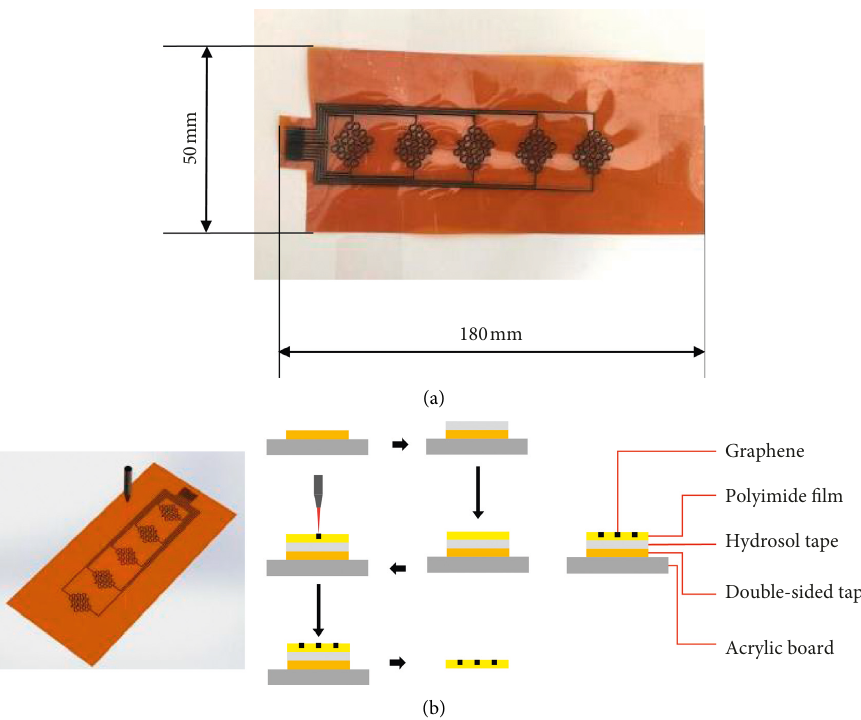
Figure 1: (a) LIG temperature sensor; (b) LIG temperature sensor manufacturing